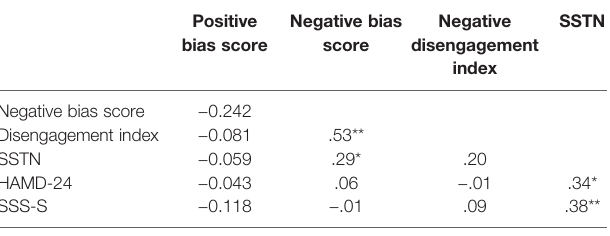
TABLE 3 | Bivariate correlations between attentional bias indices and symptoms in the depression group. Positive Negative bias bias score